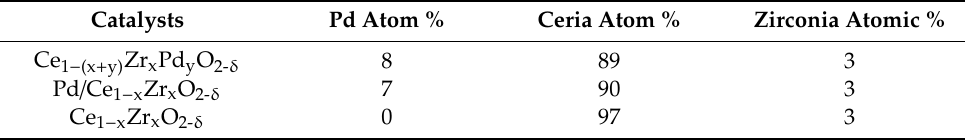
Table 2. Metal loadings as determined from ICP-OES analysis .